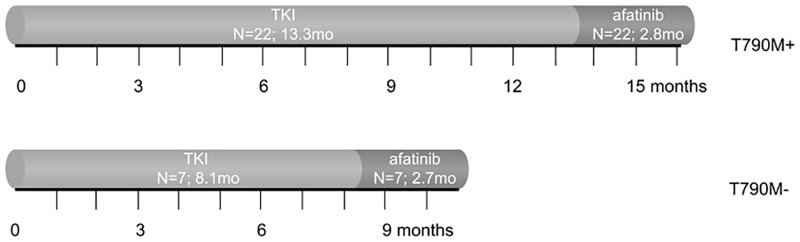
Median PFS for sequential treatments in T790M positive and negative NSCLC patients.After first generation EGFR-TKI, 22 patients had a T790M and 7 did not. All patients received afatinib, afterwards.